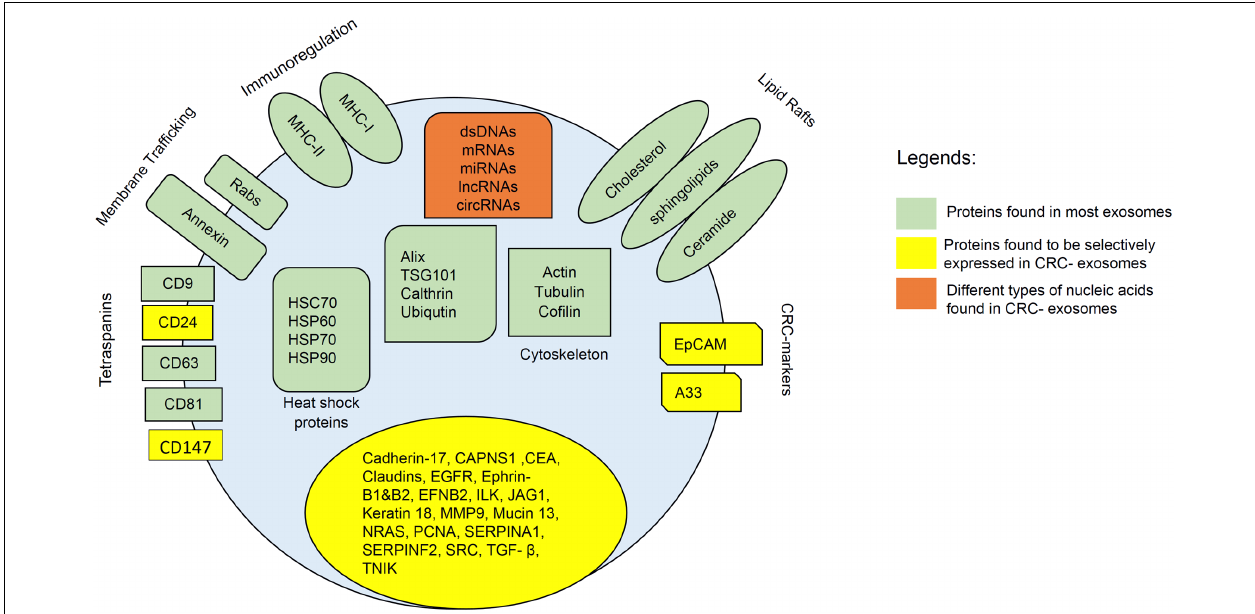
FIGURE 1 | Composition of CRC-exosomes. All exosomes carry multiple types of proteins, including major histocompatibility complex (MHC)-II, cluster of differentiation (CD), tetraspanins, heat shock protein (Hsp), Ras-related protein (Rab), signal transduction proteins, and etc. Exosomes also contain different types of lipids such as cholesterol, ceramide, and etc. In addition, exosomes contain various types of nucleic acids, including dsDNA, miRNA, mRNA, and non-coding